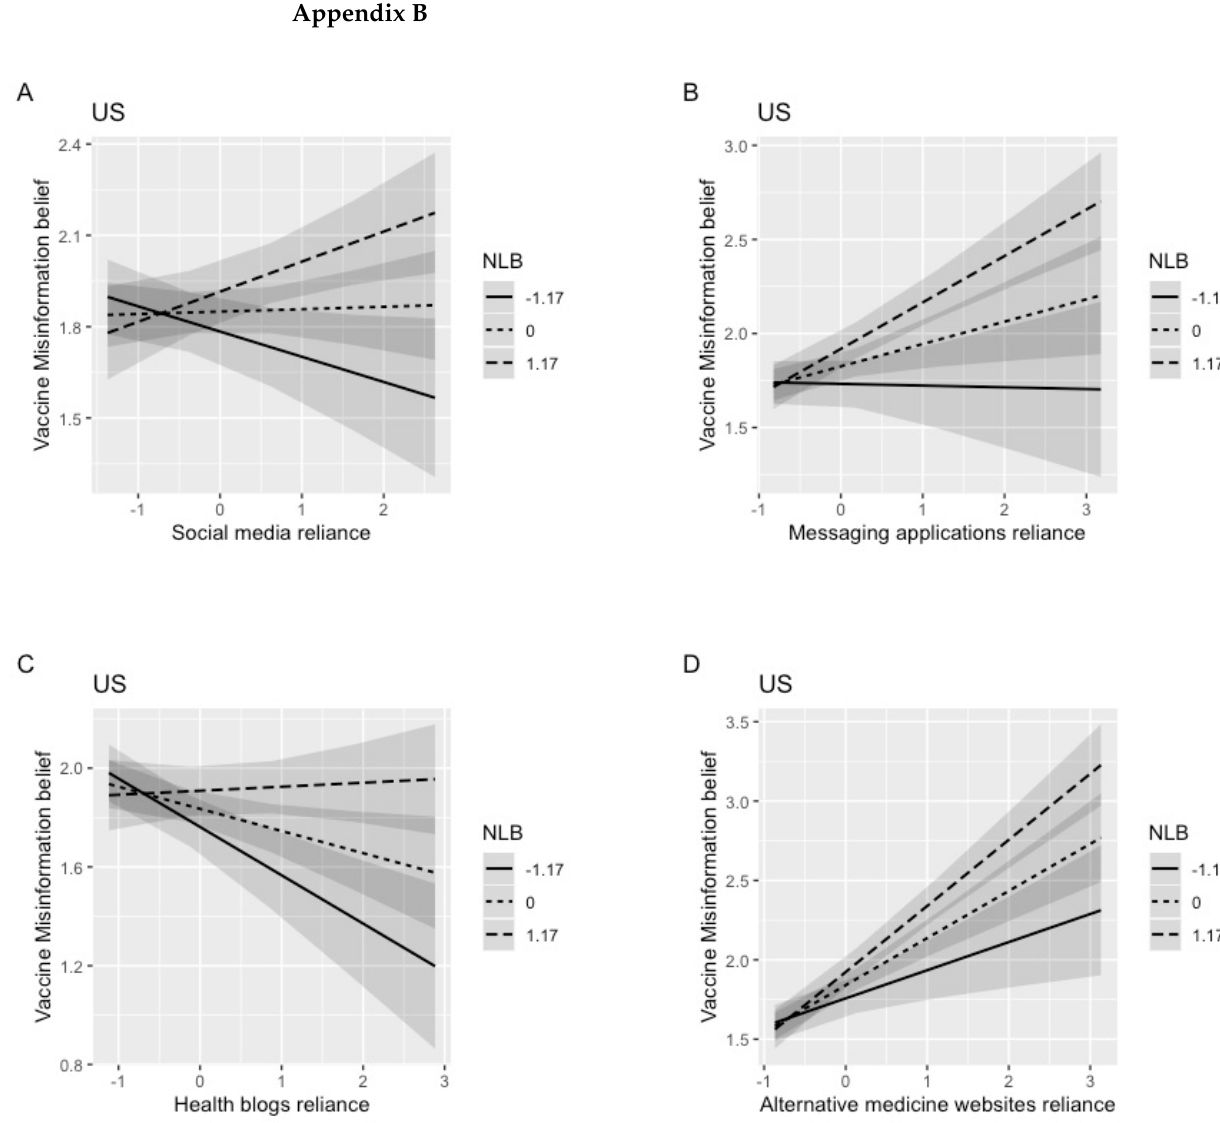
Table A4. Data analysis using 5000 bootstrap samples (moderated mediation effect).